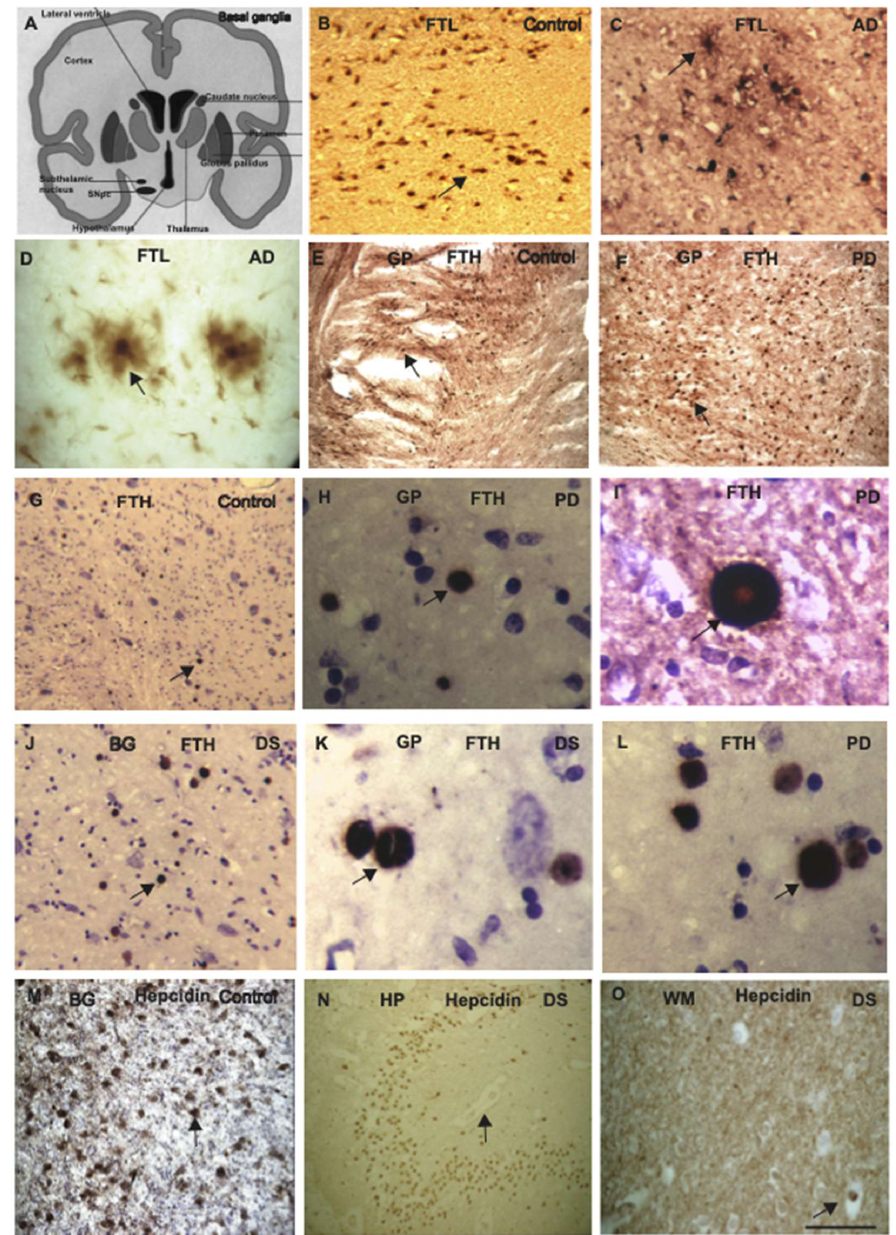
Figure 4. Ferritin light chain and heavy chain proteins localised in the globus pallidus and putamen. To investigate cellular expression of iron proteins, brain sections of AD, PD, and controls were analysed by immunohistochemistry (IHC) using DAB. A cartoon diagram showing the different part of basal ganglia (BG) analysed with DAB staining is presented ( A ). In control brains, in SNpc, a vast amount of granular neuromelanin positive for FTL was found located very close to the blood vessels ( B ); whereas in AD brain, FTL was present in the amyloid plaques ( C ); and on higher magnification it was also present in the microglia ( D ). Brain sections from BG of control and PD subjects when stained with FTH appeared loaded with small vesicles in the thalamus, globus pallidus, and putamen ( E , F ), and on higher magnification it appeared like inclusions within the striosome-matrix compartments ( G – I ), an appearance very similar to Lewy bodies ( I – L ). One control brain section from thalamus was stained with hepcidin and a very similar pattern of iron accumulation was seen, and scattered throughout the thalamus ( M ). In DS brain, hepcidin visible in the blood vessels (( N ), indicated by arrow), and express in the white matter of internal capsule ( O ). Scale bar: ( B , C , E – G , J , M – O ) = 50 µ m; ( D , H , I , K – L ) = 10 µ